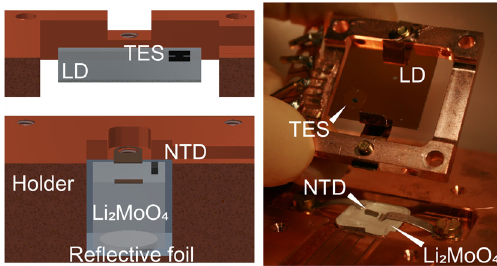
Fig. 1 Left: section view of the detector module. Right: picture of the detector module. The Li 2 MoO 4 crystal sits on a piece of PTFE inside a reflective cavity and is held in position with two bronze clamps. One NTD of (1 × 1 × 3) mm 3 is glued on the top surface of the crystal and is used as thermal sensor for signal read-out. A (20 × 20 × 0 . 3) mm 3 wafer of silicon-on-sapphire is used as light absorber, its frame is fixed on top of the target crystal. The thermal sensor is a TES directly deposited on the silicon coated side of the silicon-on-sapphire plate